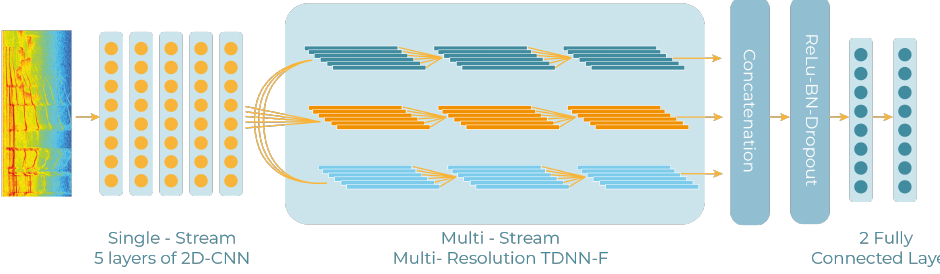
Figure 1. Architecture of the Multistream CNN acoustic model composed by an initial set of five 2D-CNN layers followed by three stacks of 17 TDNN-F layers. This figure is inspired by the one presented in